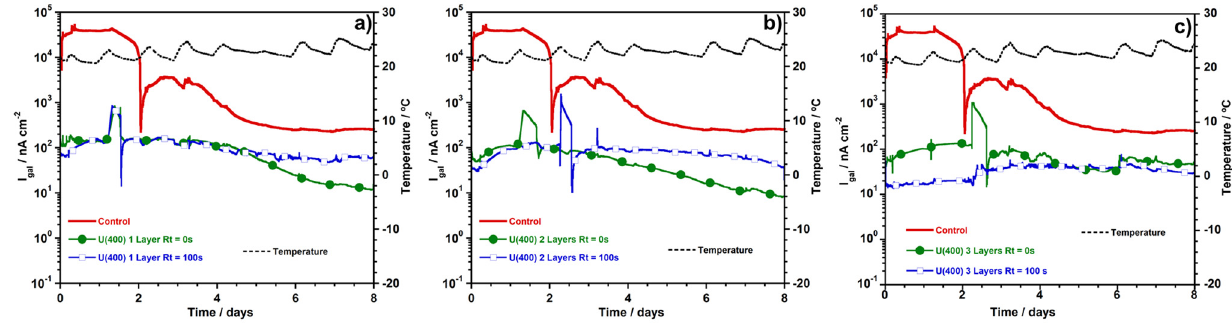
Figure 8. Plots of the variation of macrocell current density ( i gal ) and laboratory temperature with time recorded for HDGS samples coated with U(400) ( a ) one layer (Rt = 0 s and Rt = 100 s); ( b ) two layers (Rt = 0 s and Rt = 100 s); ( c ) three layers (Rt = 0 s and Rt = 100 s) with cures between each dip step in SCPS during eight